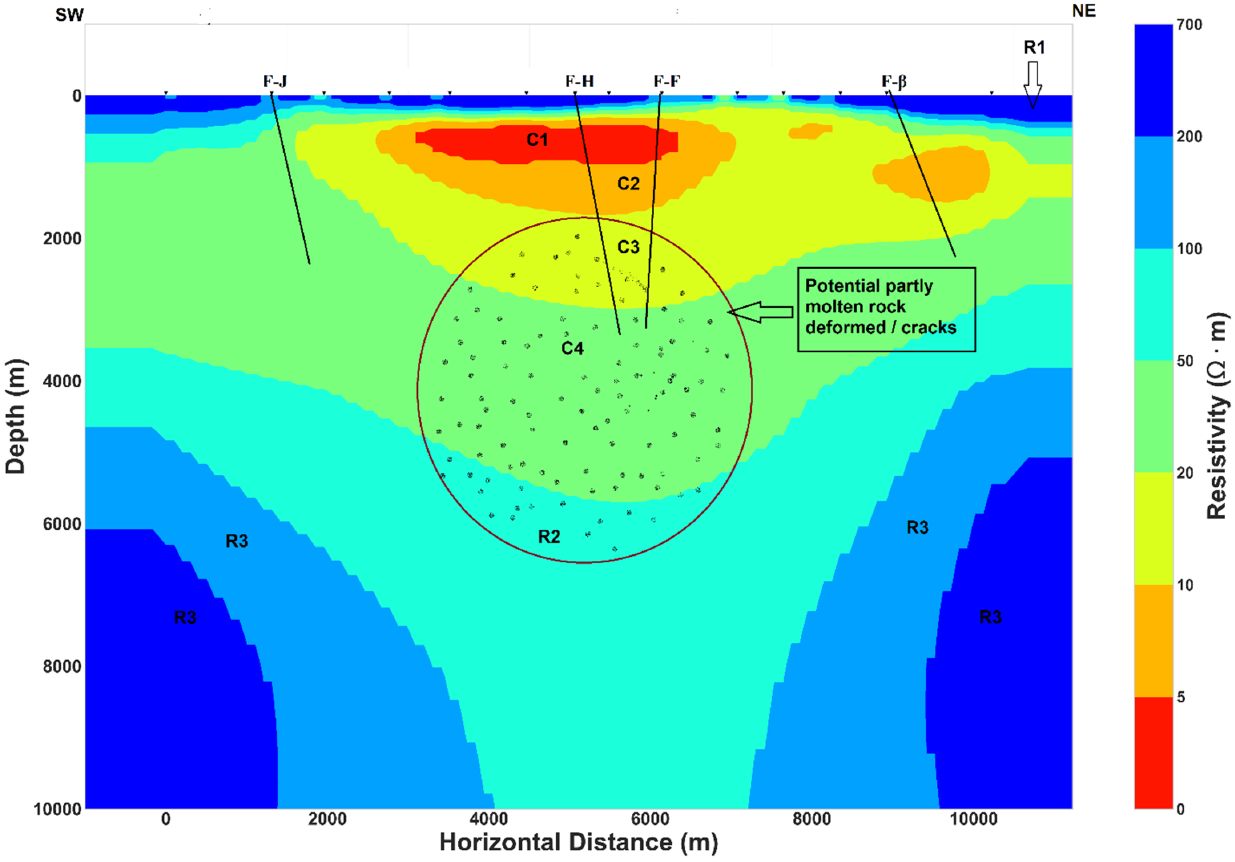
Figure A3. Conceptual model of Asal rift derived from the 2D inversion of invariant model. F-J, F-H, F-F and F- β are the main normal faults (see Figure 1).